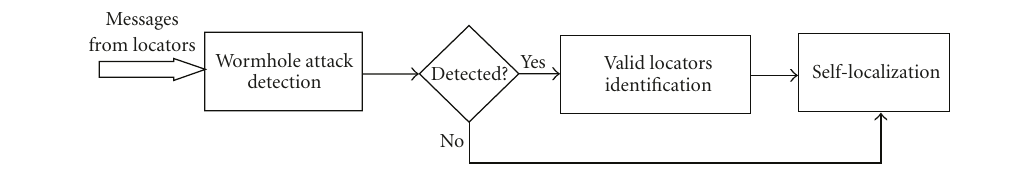
Figure 2: Flow chart of the proposed secure localization